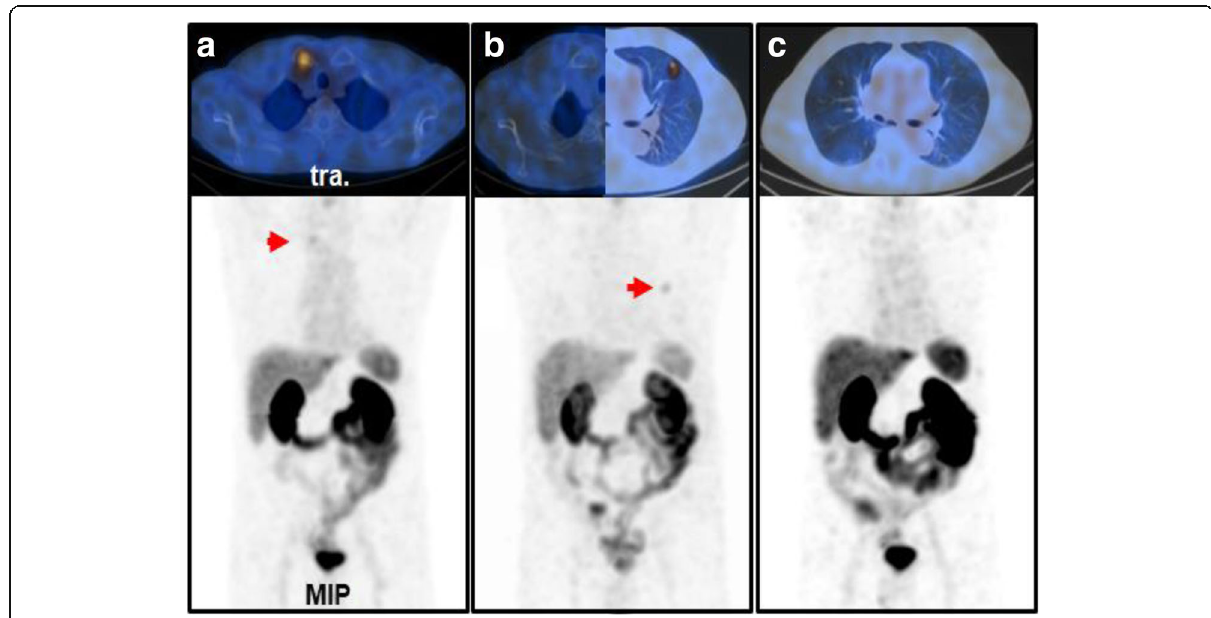
Fig. 3 Lesion detection in BCR and monitoring of radiation therapy in a 72-year-old patient with Gleason 7 PCa, who underwent primary surgery and salvage radiation therapy. a Cancer recurrence was detected in the right clavicle (PSA 3.8 ng/ml) which was followed by targeted radiation. b 6 months later the clavicle was unremarkable but another recurrence was detected in the lung (PSA 6.8 ng/ml) again followed by precision radiotherapy. c Another 6 months later, no tumor recurrence was detected (PSA 0.56 ng/ml). Note: the apparent focal PSMA-positivity in the liver ( c ) could not be confirmed in the cross-sectional planes and was not categorized as